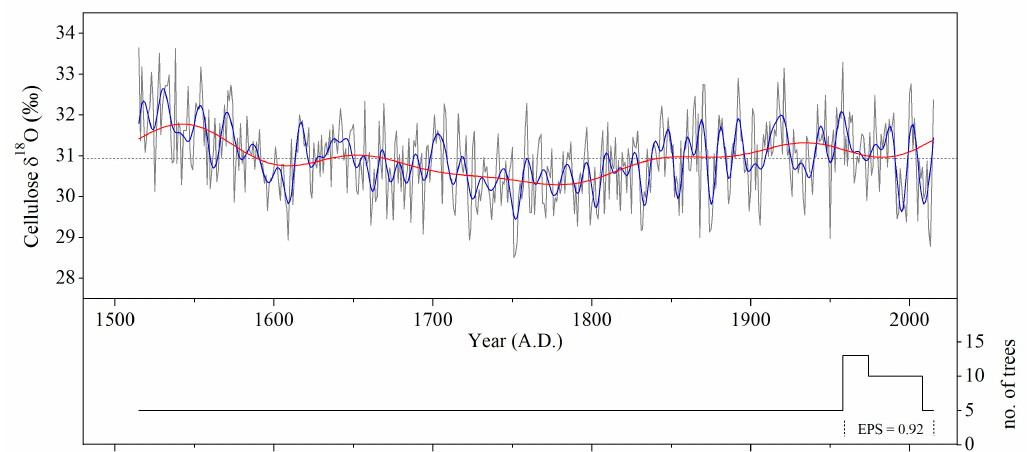
Figure 2. Tree-ring stable oxygen isotope chronology of Juniperus polycarpos from the southern slope of the Alborz Mountains over the period 1515–2015. Blue and red lines represent decadal and centennial δ 18 O variations calculated with 10 and 100 Fast Fourier transform (FFT)-Filters, respectively. The overall mean value of the tree-ring δ 18 O chronology (horizontal black dotted line) and the number of trees included in the chronology are presented in the lower panel. Table 1. Chronology statistics of the δ 18 O time series of J. polycarpos in northern Iran.